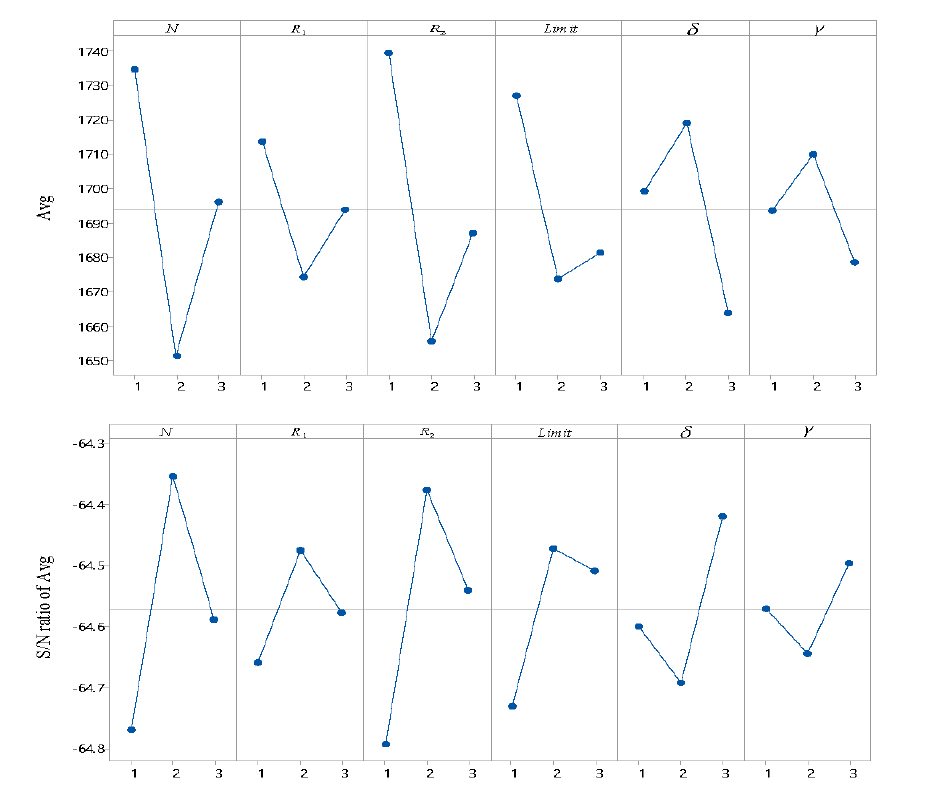
Figure 10. Mean Avg and mean S/N